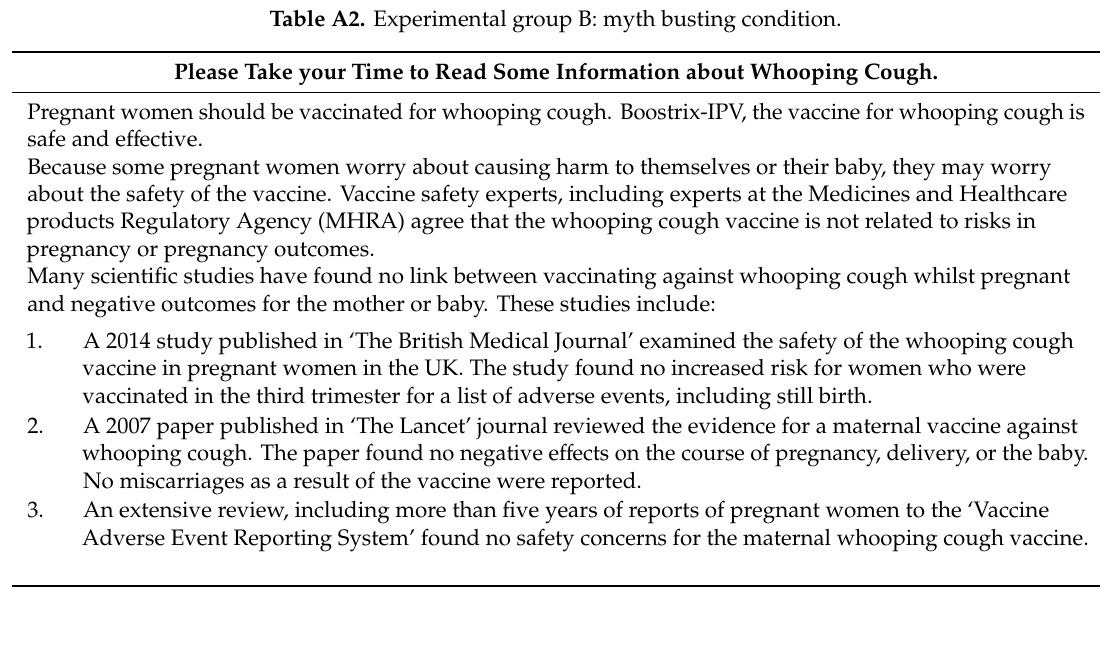
Table A2. Experimental group B: myth busting